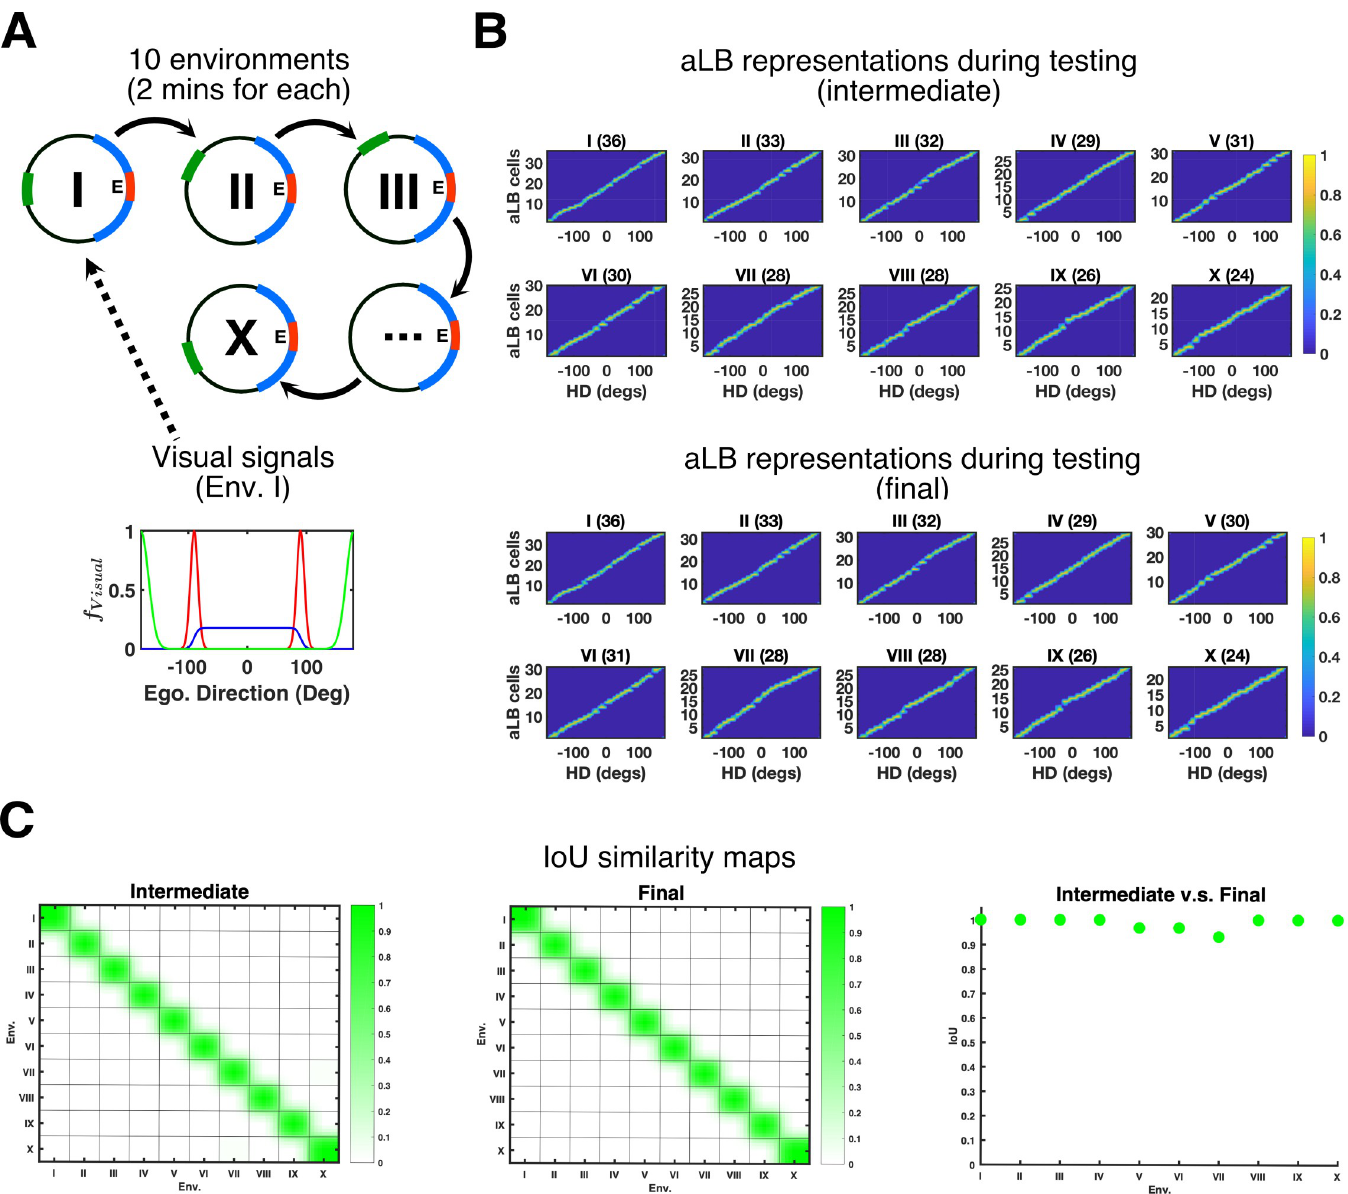
Fig 4. aLB cells show high encoding capacity across multiple environments. (A) The agent is exposed to 10 environments sequentially (top) with feature-specific visual input signals due East in Env. I (bottom). Sceneries contain ‘red’ and ‘blue’ cues, common to all environments, and a ‘green’ cue, at an orientation relative to the other two cues that change between environments. (B) Global representations of aLB cells with local weights tested on corresponding sceneries. Titles for each plot refer to the corresponding environment in (A), along with the total number of highly activated aLB cells in brackets. The ’intermediate’ plots provide aLB cell activity based on weights after the first exposure in each individual environment. The ‘final’ plots provide aLB cell activity based on weights after the learning in all 10 environments is complete. See Fig 2D for illustrations. Warmer colors represent higher firing rates. (C) IoU similarity maps measuring the similarity of two sets of aLB cell firing patterns when tested on specific sceneries. Axes refer to environments, with 1 as the earliest (i.e. Env. I). The left column provides IoU maps based on ‘intermediate’ weights. The middle column provides IoU map based on ‘final’ weights. The right column provides the IoU index (y-axis) between the first exposure and the end of learning tested on each scenery (x-axis). Green colors represent higher IoU, of which the maximum is 1. Abbreviations: HD: head direction; Env.: Environment; Ego.: Egocentric; aLB: abstract landmark bearing; IoU: Intersection over Union; f : firing